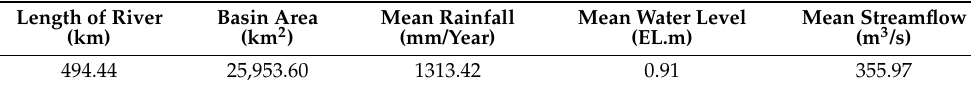
Table 2. Summary of site characteristics.